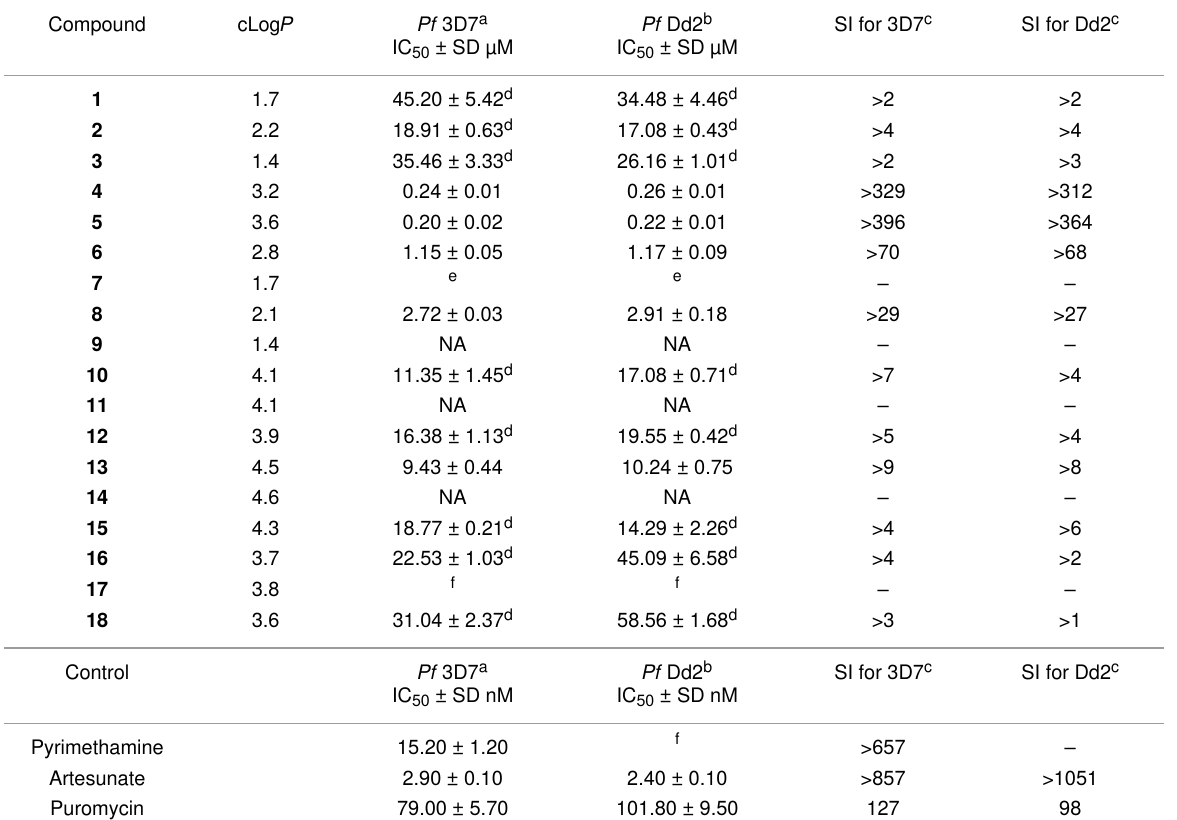
Table 1: Biological data for triazolopyrazine analogues 1 – 18 .